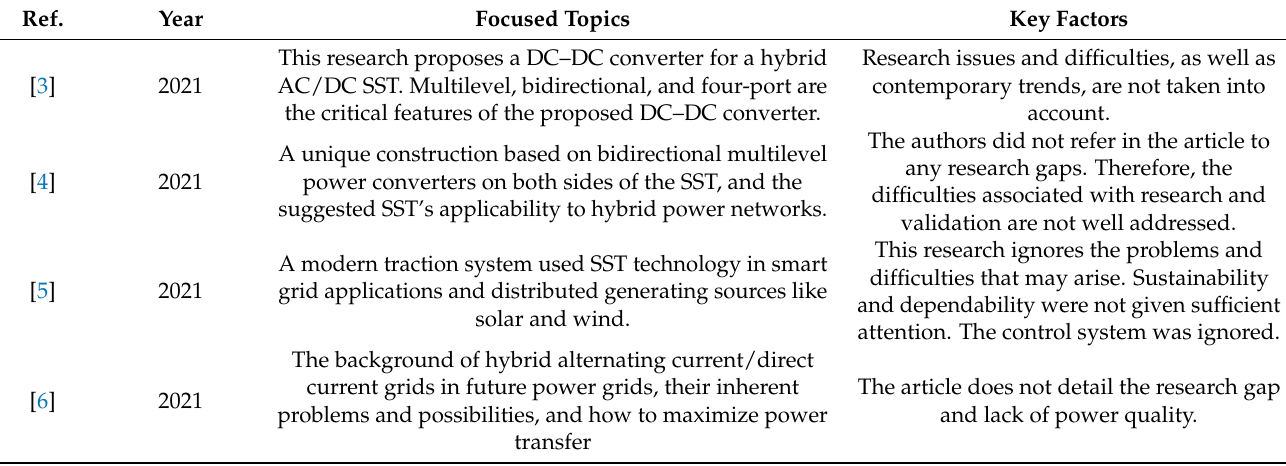
Table 1. Research topics and key factors of SST technology.